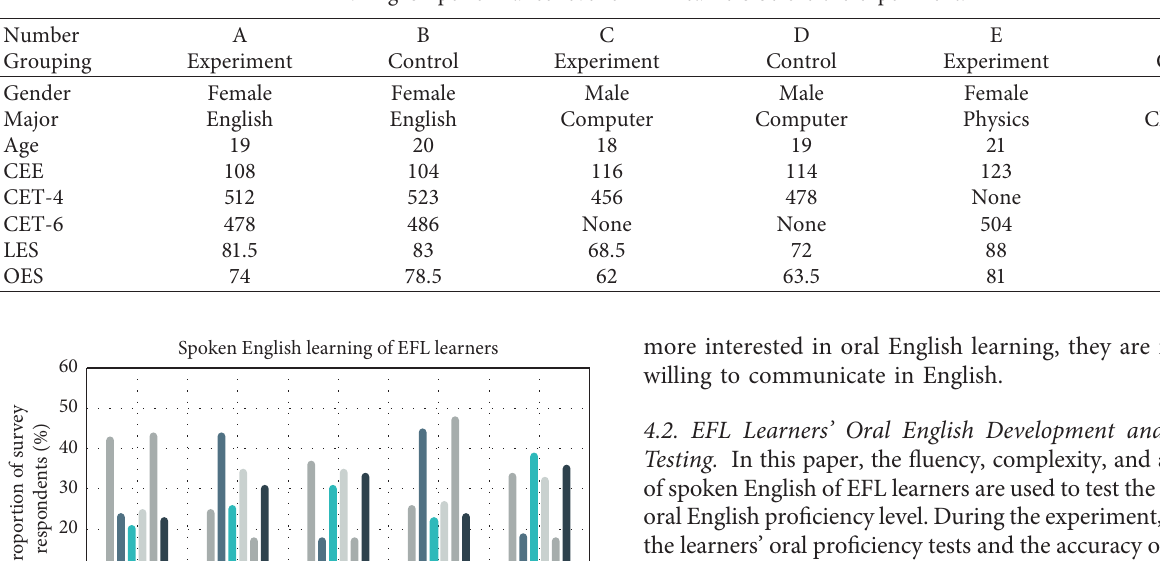
Figure 1: Experimental process of oral English teaching for EFL learners. Table 2: English performance level of EFL learners before the experiment.